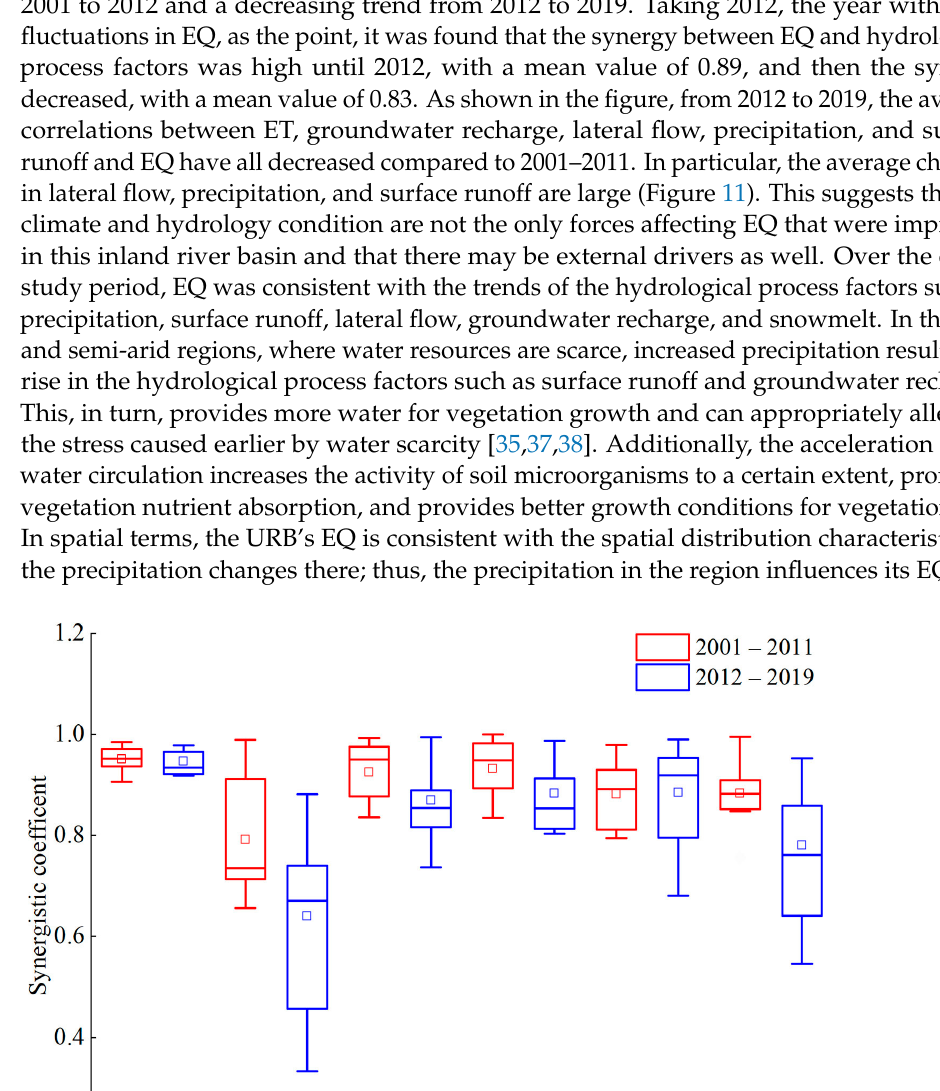
process factors and EQ over the last 19 years was higher than 0.7. The synergy between the two was lower in the western and southern parts of downstream URB. This synergy